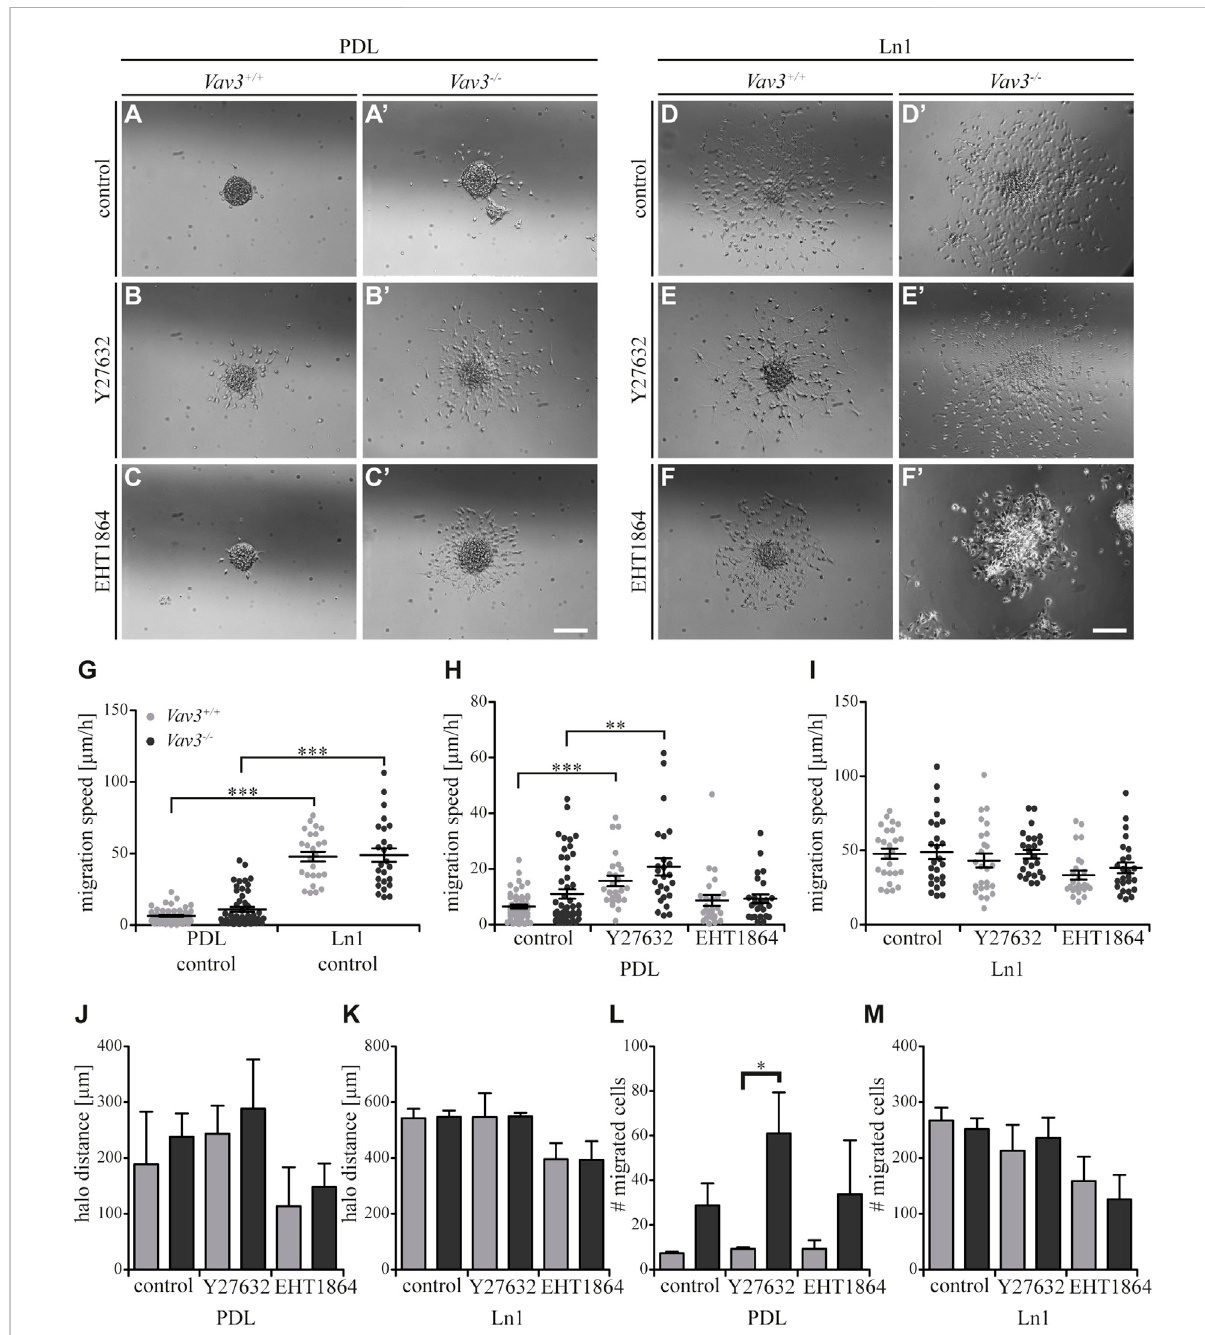
FIGURE 3 Effect ofinhibited Rho GTPase signaling onOPC migration onPDL andlaminin-1. (A +A 9 ) Control condition ofoligospheresof either genotype onPDLwithouttreatment(after24 h). (B +B 9 ) Blockage ofROCK bytreatment withY27632 inhibitorinoligospheres ofboth genotypes onPDLafter 24 h. (C+C 9 ) BlockageofRac1bytreatmentwithEHT1864inhibitorinoligospheres ofbothgenotypesonPDLafter24 h. (D+D 9 ) Controlcondition of oligospheres of either genotype on Ln1 without treatment (after 24 h). (E + E 9 ) Blockage of ROCK by treatment with Y27632 inhibitor in oligospheres of both genotypes on Ln1 after 24 h. (F + F 9 ) Blockage of Rac1 by treatment with EHT 1864 inhibitor in oligospheres of both genotypes on Ln1 after 24 h. (G) Quanti fi ed migration speed of PDL and Ln1 control conditions without treatment. Signi fi cantly impaired migration speed was observed on PDL compared to Ln1 in both genotypes. (H) The quanti fi cation of the migration speed of OPCs from oligospheres of either genotype on PDL indicated a RhoA-related migration behavior, independent of Vav3. (I) The quanti fi cation of migration speed of OPCs from oligospheres of either genotype on Ln1 indicated a very mild involvement of Rac1, as migration speed was not heavily affected by Rac1 inhibition. (J) The halo distance slightly supported a restrained involvement of RhoA in migration behavior of OPCs of either genotype on PDL. Inhibition of Rac1 caused a decreased halo distance that was statistically not signi fi cant. (K) The halo distance of OPCs of either genotype supported the involvement of Rac1 in